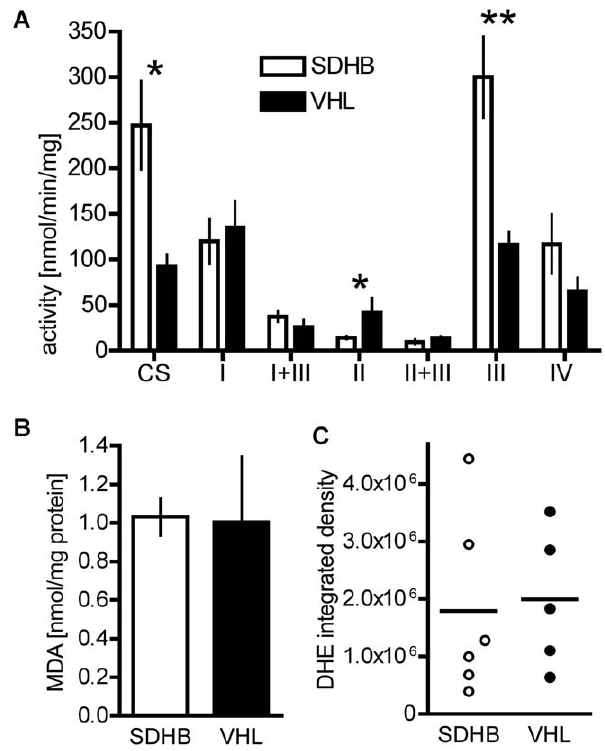
Figure 5. Tumor tissue levels of oxidative phosphorylation complex activity and oxidative stress. A Oxidative phosphoryla- tion complex complex activity in SDHB- (n=4) and VHL-derived (n=4) PHEO/PGL tissue. * indicates p , 0.05. B Malondialdehyde level in SDHB (n=5) and VHL (n=5) tissue as a measure of lipid oxidation. C Integrated density of DHE fluorescence in VHL (n=5), SDHB